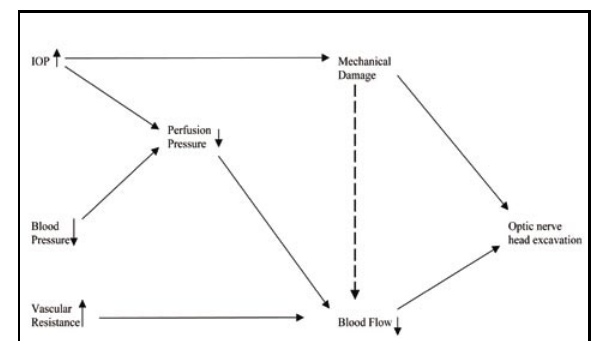
Figure 1 : Concept for the possible pathogenesis of the glau- comatous damage. (Courtesy Prof AA